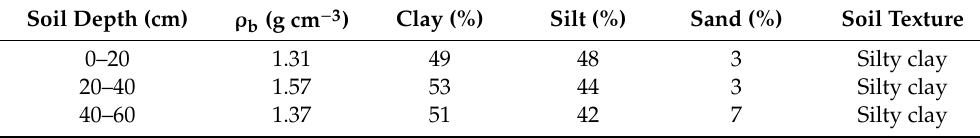
Table 1. Soil physical properties in three sampling depths.